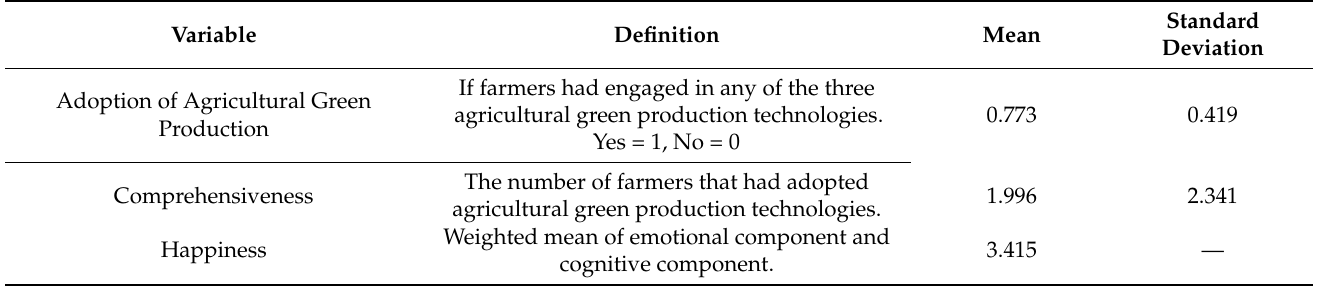
Table 1. Variable definition and descriptive